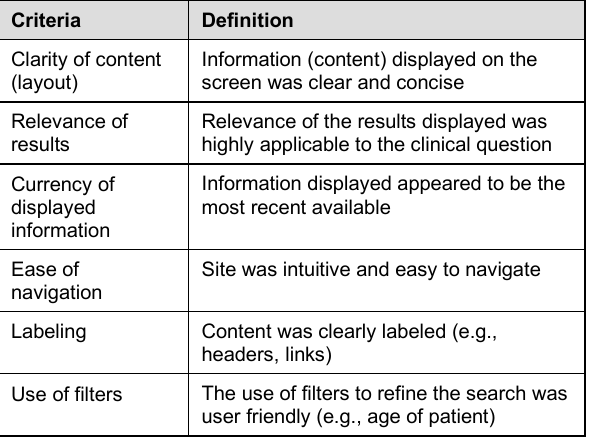
Table 1 Evaluation Criteria for Likert